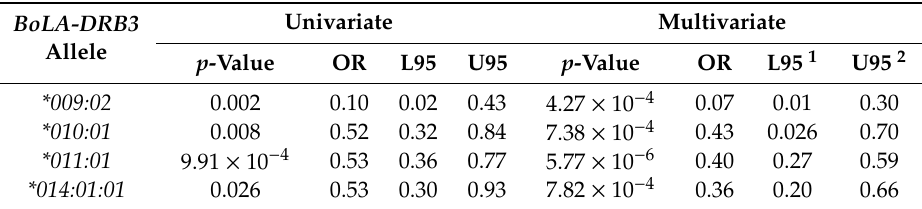
Table 3. Logistic regression analysis-based association study of BoLA-DRB3 alleles in asymptomatic and lymphoma cows after adjustments for age.